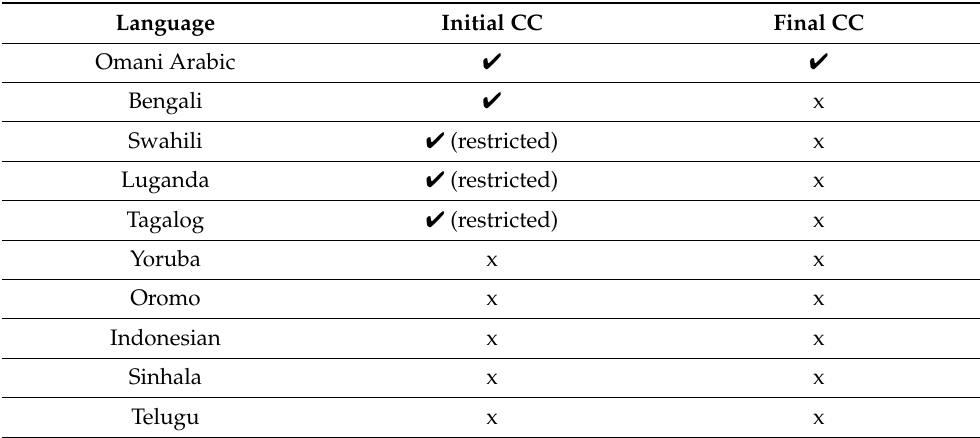
Table 1. The sound inventory of Omani Arabic (The highlighted consonants are absent from the L1 inventories of the FDH).